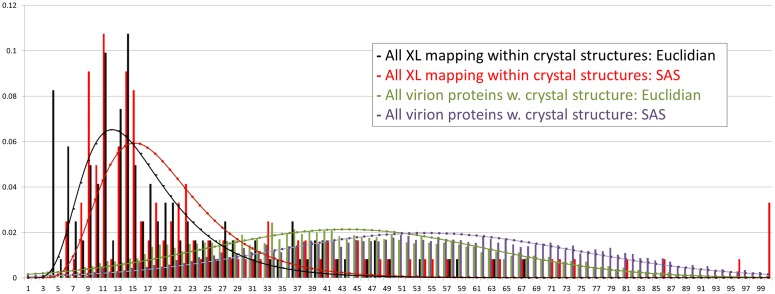
Histograms (bars), and fits (lines) to the histograms, showing all lysine-lysine Cα –Cα Euclidian (green) and SAS (purple) distances from within all virion proteins whose crystal structures have been reported to date (Table B in S1 Text; overlay = normal distribution).Superimposed are Euclidian (black) and SAS (red) distances between those crosslinked residues in our dataset that mapped within these structures (overlay = log-normal distribution). X: Distance (Å). Y: Proportion of total (ie. of all values summed for a histogram or distribution) found within an individual bar or point. XL lengths < 32 Ǻ were considered structurally rational for crosslinkers DSS/BS3. For the longer crosslinkers BSPEG5/9, no XL exceeded an SAS distance of 30 Å. For zero-length XL (EDC), Cα –Cα SAS distances for crosslinked residues of < 18.6 Å were considered structurally rational. The few violators of these restraints likely represent inter-subunit XL within homomultimers as opposed to intra-protein XL. Distances for Vaccinia Profilin were based on a homology model of the Monkeypox ortholog (PROF_MONPZ, Table B in S1 Text).